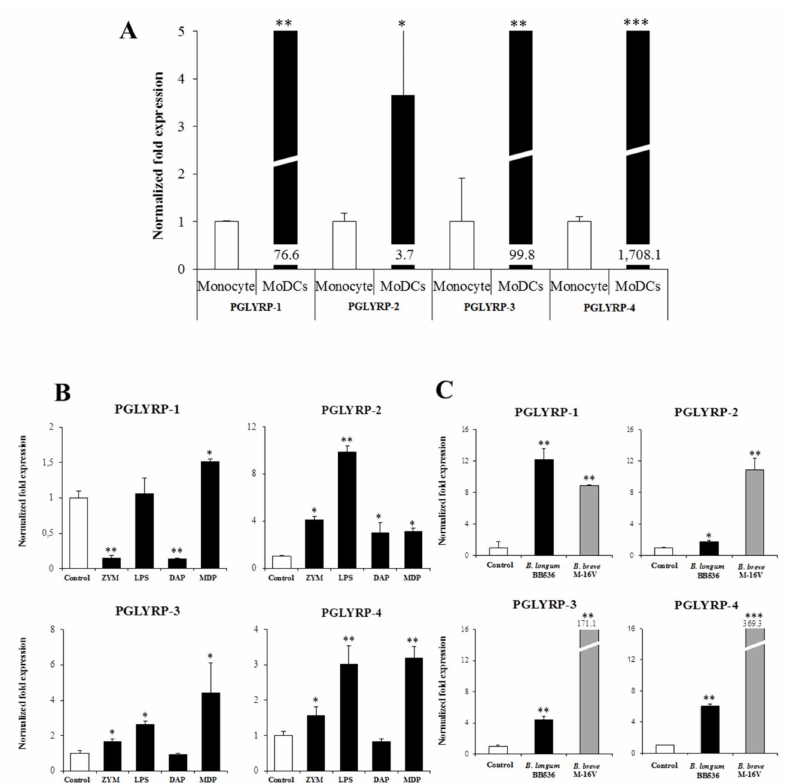
Figure 3. Peptidoglycan recognition proteins (PGLYRPs) expression in porcine blood monocytes and monocyte-derived dendritic cells (MoDCs) and their modulation by pattern recognition receptor (PRR)-ligands and paraimmunobiotic bifidobacteria. Expressions of PGLYRPs in porcine blood monocytes and MoDCs without stimulation ( A ). PGLYRPs expressions in porcine MoDCs stimulated with PRR-ligands: zymosan (ZYM), lipopolysaccharide (LPS), muramyl tripeptide (DAP), and muramyl dipeptide (MDP) ( B ). PGLYRPs expressions in porcine MoDCs stimulated with paraimmunobiotic bifidobacteria: Bifidobacterium longum subsp. longum BB536 or B. breve M-16V ( C ). PGLYRP mRNA expressionlevelwasnormalizedusingtheporcine β -actinmRNA,andtherelativeindexwasdetermined by comparison to the PGLYRP mRNA level in monocytes or control MoDCs (1.00). Values represent the means ± standard deviation obtained from three independent experiments ( n = 6). * p < 0.05, ** p < 0.01, *** p < 0.001 against either monocytes ( A ), or control ( B